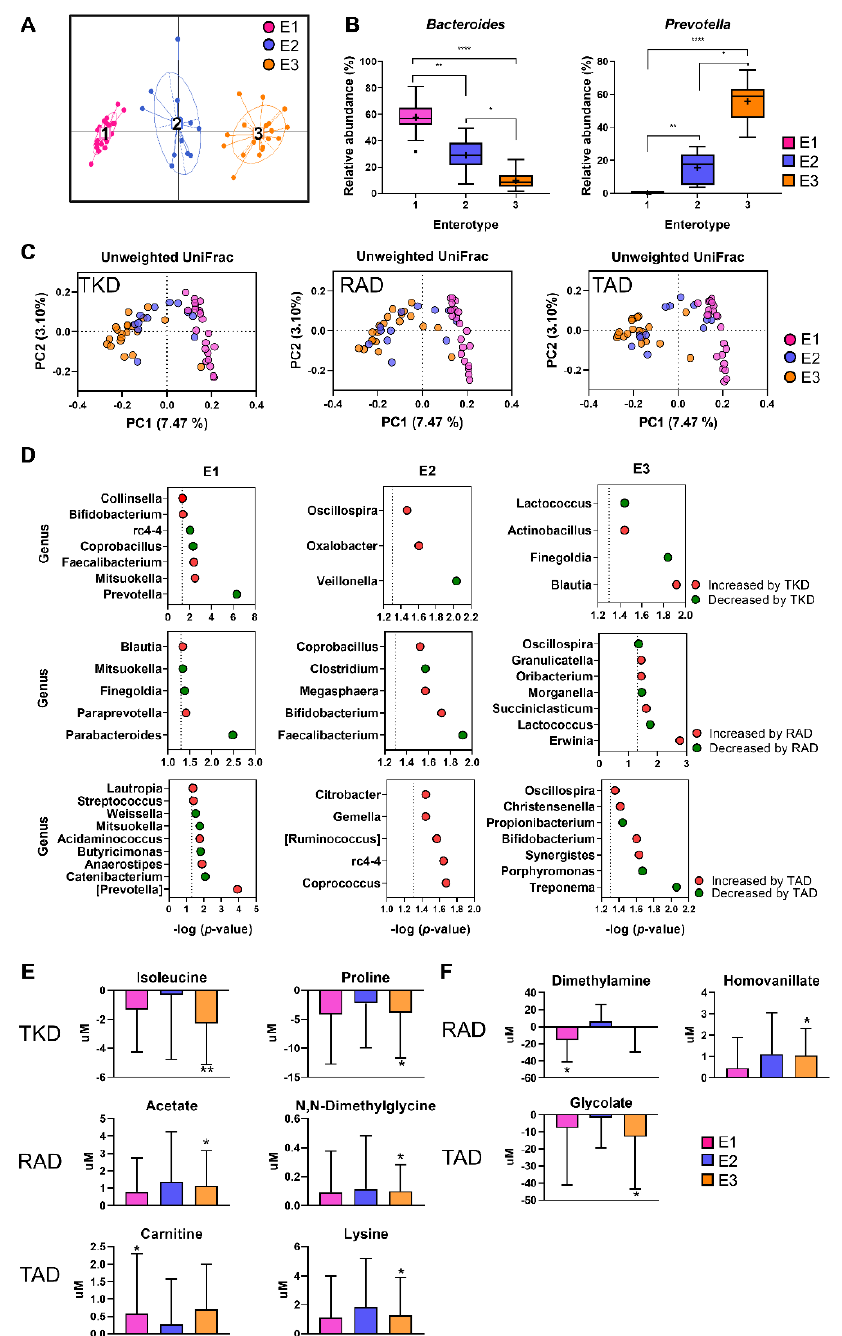
Figure 4. Effect of enterotypes on the microbial and host responses to experimental diets. ( A ) Classification of enterotypes by principal coordinates analysis of 54 individuals based on the composition of the genus level relative abundance profiles. ( B ) Tukey box and whiskers plots of the relative abundance of Bacteroides and Prevotella in each enterotype. Asterisk represents statistical significance (* p < 0.05, ** p < 0.01, **** p < 0.0001; Kruskal–Wallis followed by a Dunn’s multiple comparisons test). ( C ) PCoA plot of the unweighted UniFarc distances of gut microbial composition from three enterotypes after TKD, RAD, and TAD intervention. ( D ) Changes in the relative abundance of genera from before to after intervention were evaluated by Wilcoxon Signed-Rank test in each enterotype. Enterotype-specific increased and decreased bacterial genera colored red and green, respectively. The x-axis indicates the −log 10 of the p -value of each genus from Wilcoxon Signed- Rank test between before and after each dietary intervention in each enterotype. Metabolites changes in serum ( E ) and urine ( F ) according to enterotype after each diet intervention. The y-axis indicates changes of concentrations of the metabolites (C After minus C Before ). Significant differences between the